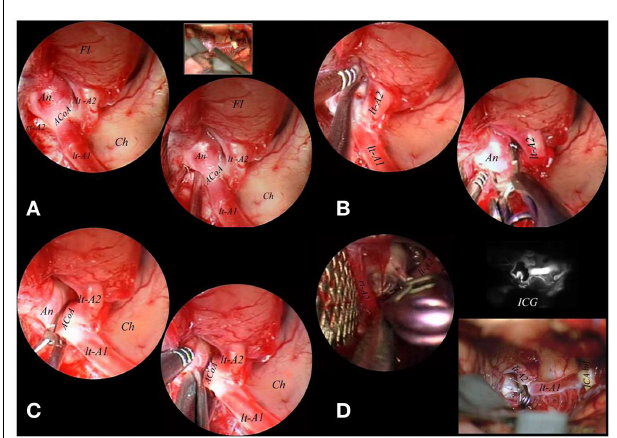
FIGURE 4 |The endoscope was fixed to a mechanical holder and the rightA2 tract was freed from the medial border of the implant base under endoscopic control (A) . Also the left A2 tract directly originating from the right A1 tract was dissected from the lateral border of the basal portion of the aneurysmal sac and a clip was applied under endoscopic control (B) . After definitive clipping was obtained, the sac was opened with microscissors to confirm complete exclusion (C) . A final inspection with the endoscope used free-hand evidentiated the complete exclusion of the lesion which was confirmed by intraoperative indocyanin green fluoroangiography (D) . A1, proximal segment of the anterior cerebral artery; A2, postcommunicating segment of the anterior cerebral artery; ACoA, anterior communicating artery; An, aneurysm; Ch, chiasma; Fl, frontal lobe; ICA bif, bifurcation of internal carotid artery; ICG, indocyanin green fluoroangiography; lt, left; M1, proximal segment of the middle cerebral artery; rt, right.